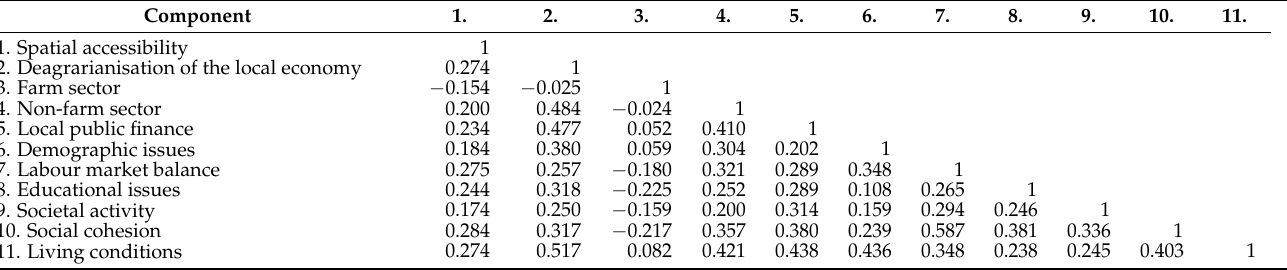
Table 2. Kendall’s tau correlation